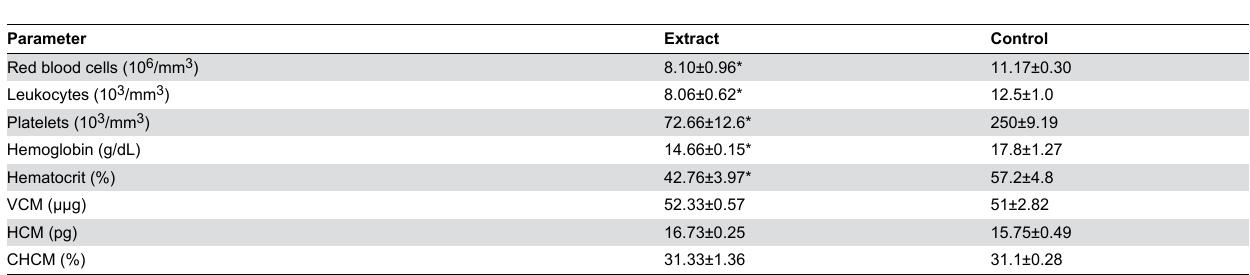
Data are presented as mean ± standard deviation, with 3 animals per group. *p<0.05 with compared to control by ANOVA followed by Newman-Keuls test. doi: